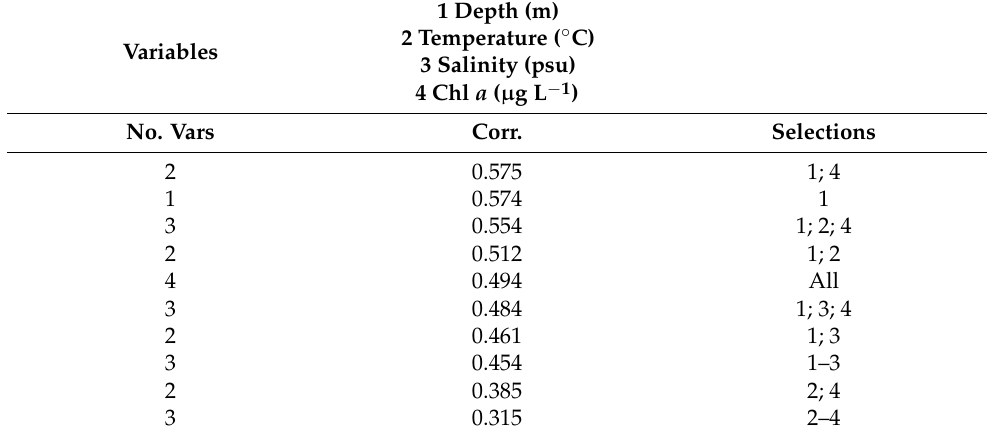
Table 1. Results of BEST test.